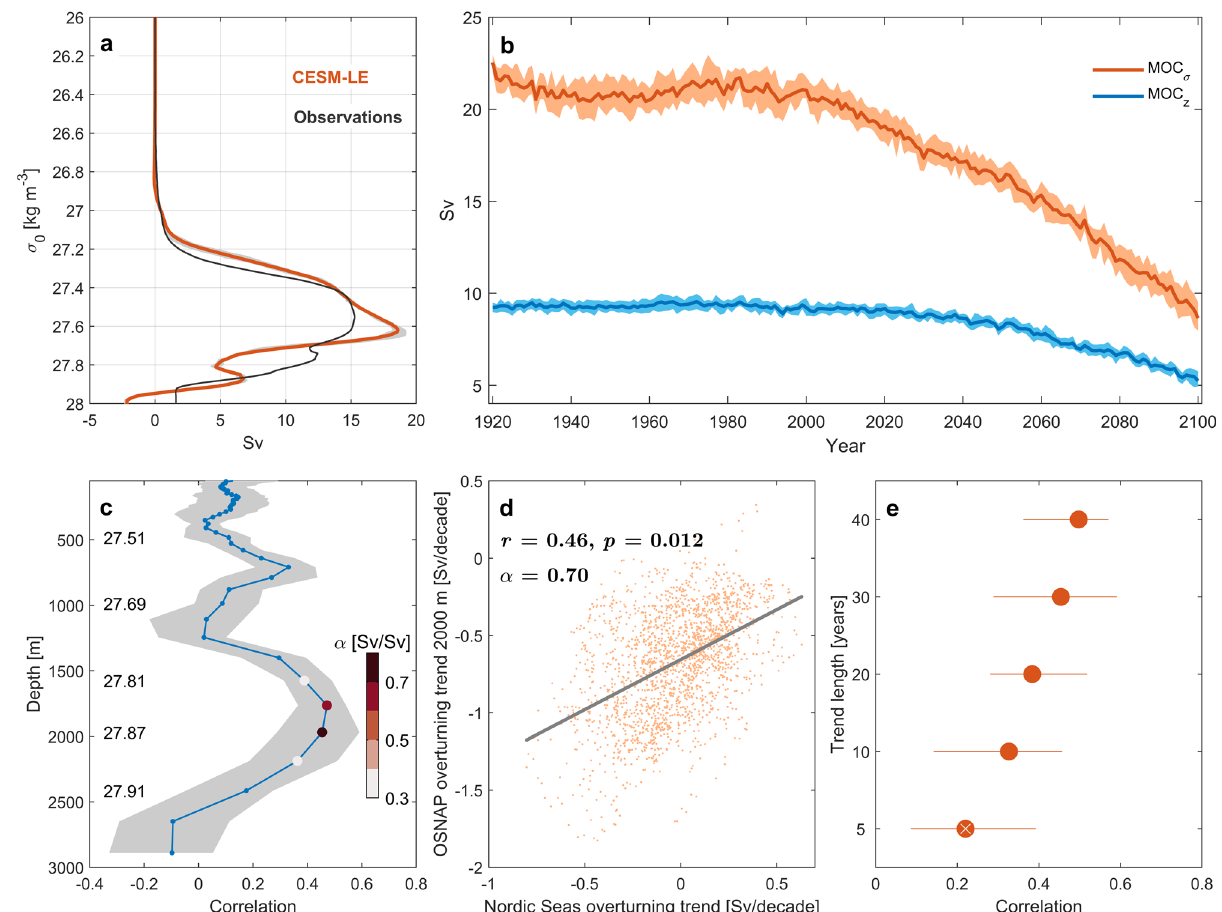
and the shading indicates the interquartile spread. Colored circles show the ensemble trend regression slope α for signi fi cant correlations at the 95% con- fi dence level. d Relationship between Nordic Seas overturning trends and OSNAP- East overturning at 2000m. The ensemble trend correlation ( r ) and regression slope ( α ; OSNAP-E overturning trends regressed onto Nordic Seas overturning trends) are provided. e Ensemble trend correlations for different trend lengths for OSNAP-East overturning at 2000m. Red circles show the mean value and the horizontal lines indicate the interquartile spread. White cross indicates non- signi fi cant